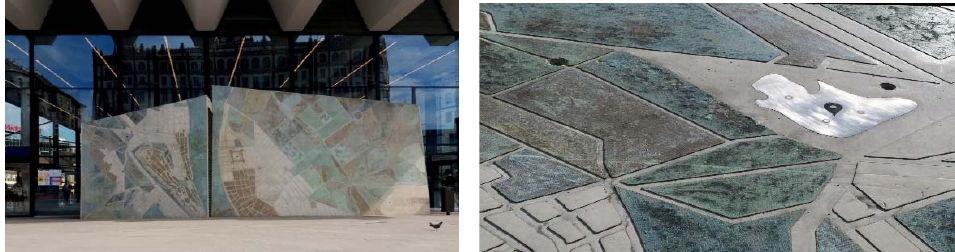
Figure 6. The two monumental units of the exposed concrete relief map ( left ), and a detail of the map ( right ) with the 1823 depiction of Széll Kálmán Square. (Photos by the authors, 2019).